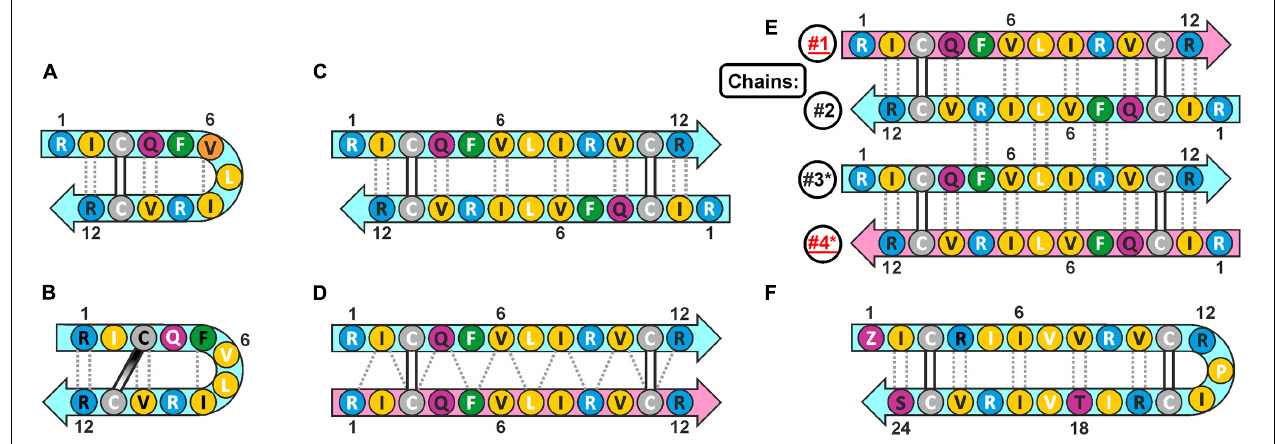
FIGURE 1 | The possible secondary structures of monomeric and dimeric cathelicidins-1 (bactenecins) by the example of ChDode. (A) Monomeric β -hairpin with γ -turn proposed by computer modeling (Romeo et al., 1988). (B) Monomeric β -hairpin with β -turn according to NMR data measured in water (Raj et al., 2000). (C) Antiparallel disulfide linked homodimer according to NMR data measured in water (present report). (D) Proposed structure of parallel disulfide linked homodimer (Storici et al., 1996). (E) Antiparallel non-covalent dimer of the antiparallel disulfide linked homodimers according to NMR data measured in DPC micelles (present report). The chains of the tetramer are numbered. The * marks the chains of the second homodimer in the tetramer. (F) Monomeric 24-residue β -hairpin cathelicidin-1 from the sperm whale Physeter catodon (present report). The residues of the peptide are color coded according to their properties. The aromatic, hydrophobic, basic, polar, and Cys residues are shown as green, yellow, blue, magenta, and gray circles, respectively. The residues with side-chains directed up from the picture plane (toward readers) are marked by black labels; the residues with side chains directed down from the picture plane are marked by white labels. The mainchain–mainchain hydrogen bonds are shown by dotted lines. In asymmetric oligomers (D,E) the non-symmetrical β -strands (peptide units) are colored differently.